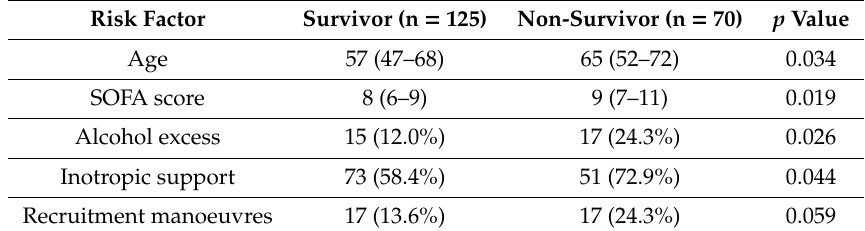
Table 5. Univariate analysis of factors associated with patient mortality. Data are median (IQR) or n (%). p -value < 0.05 is bold and